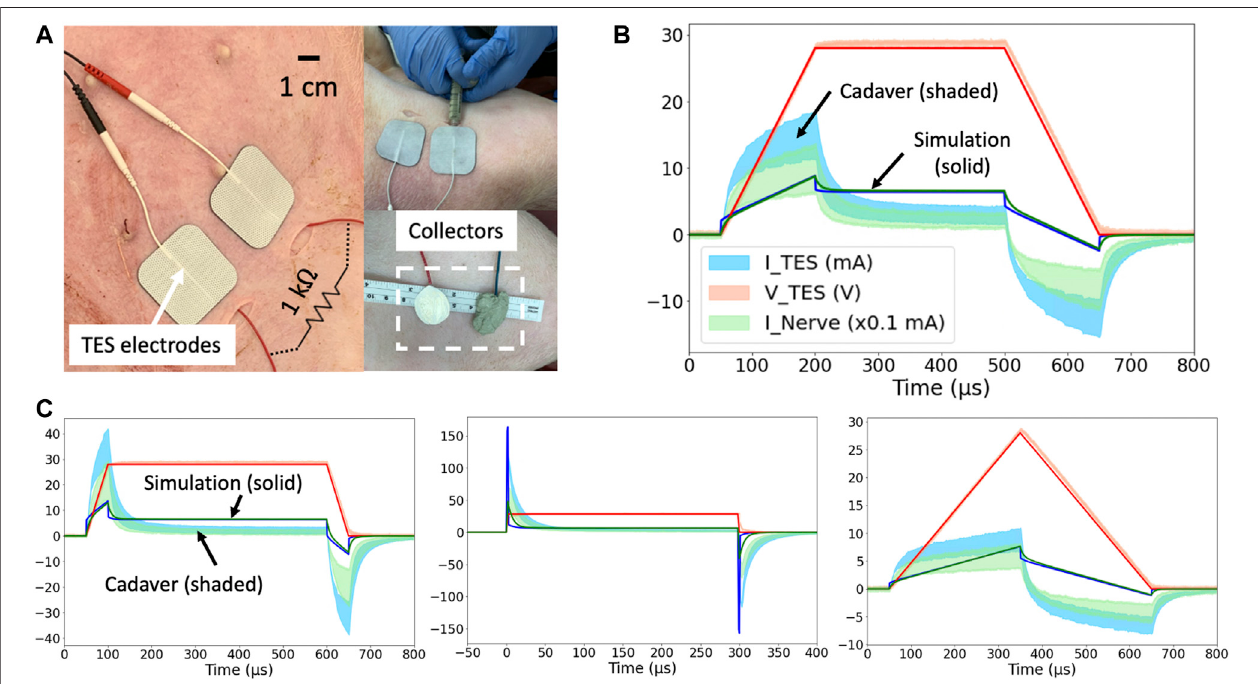
FIGURE4|(A) Domesticswinecadaververi fi cationoftheFEMmodelusingstainless-steeldiscs. (B) 28 Vvoltage-controlled600 μ spulseswith150 μ sriseandfall times.Threesolidlinesaresimulationresults,andthreeshadedareasarecadavermeasurements ± oneSD( n (cid:1) 8measurementsfrombothsidesof n (cid:1) 4cadavers).Red solid line (simulation) and shaded area (cadaver validation measurements) represent voltage of applied stimulation waveform, blue represents current through surface electrodes,andgreenrepresentsnervecurrent(scaledbyx0.1 mAforvisualization).Adarkergreencolorisseenatregionswheretheblueandgreenshadedareas overlap. (C) 28 V voltage-controlled pulses of 600 μ s duration with 50 μ s rise and fall times (left) , 300 μ s duration with fastest ( ∼ 2 μ s) rise and fall time (center) , 600 μ s duration with 300 μ s rise and fall times (right) . Note: 50 μ s rise time (left) is n (cid:1) 7 measurements due to the incorrect application of waveform amplitude in one sample. These cadaver data, overlayed with adjusted tissue values more representative of swine skin are shown in Supplementary Material S4